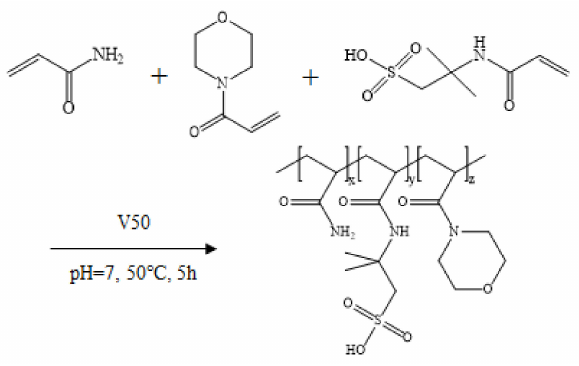
Figure 13. The synthesis process of